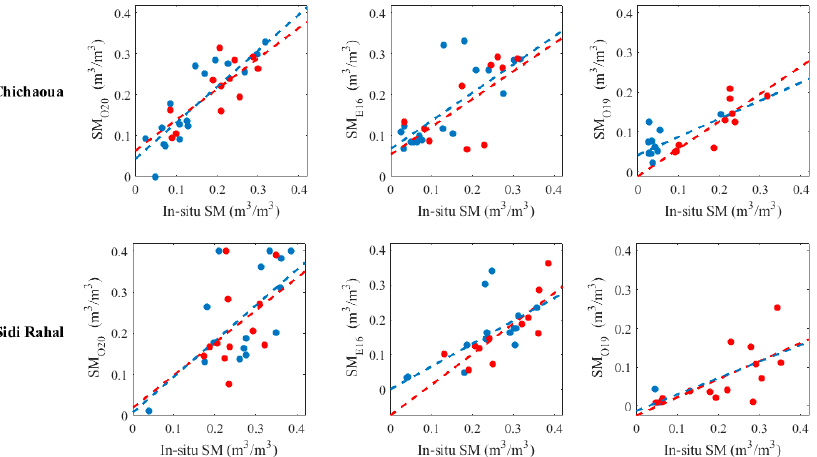
Figure 3. Retrieved soil moisture (SM) (from left to right columns: SM O20 , SM E16 , SM O19 ) versus in-situ measurements at the Chichaoua and Sidi Rahal sites. Red points correspond to dates that coincide with the same date of the Landsat overpass. Blue points correspond to dates with a one- or two-day offset with the Landsat overpass. Table 1. Statistical parameters for validation results of satellite retrieved soil moisture (SM) at the Chichaoua and Sidi Rahal sites.